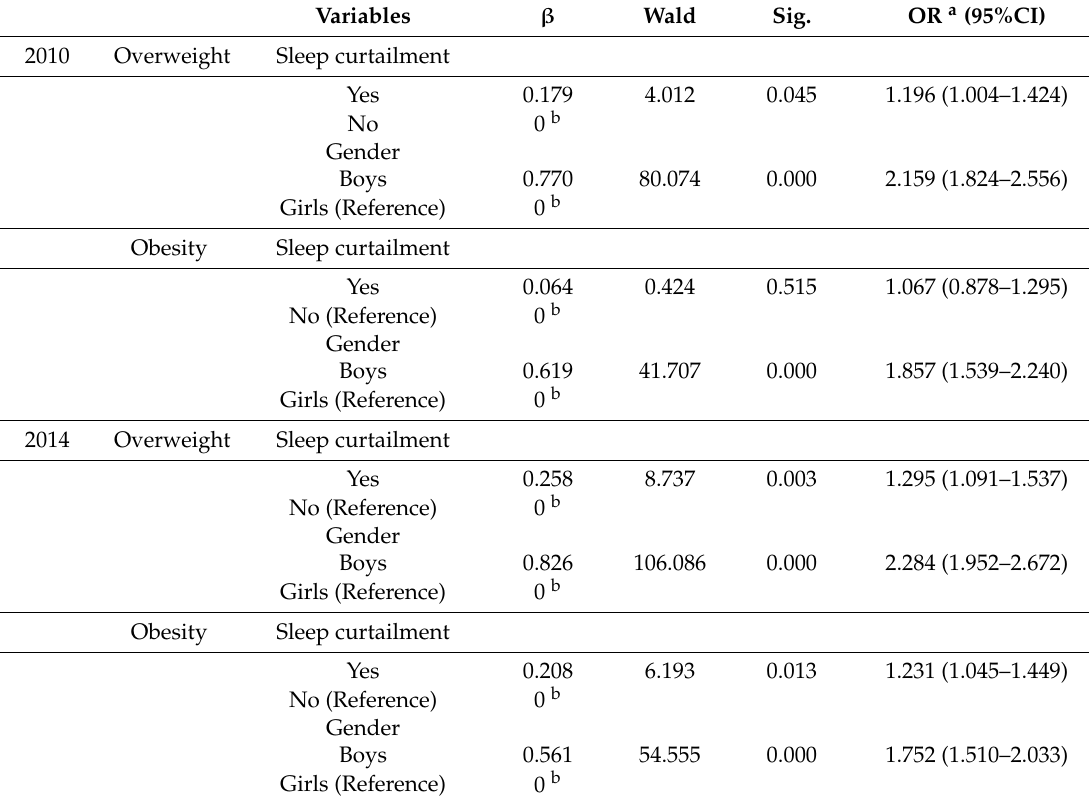
Table 7. Association between sleep curtailment and overweight or obesity stratified by age group in 2010 and 2014 (7–12-year age group).